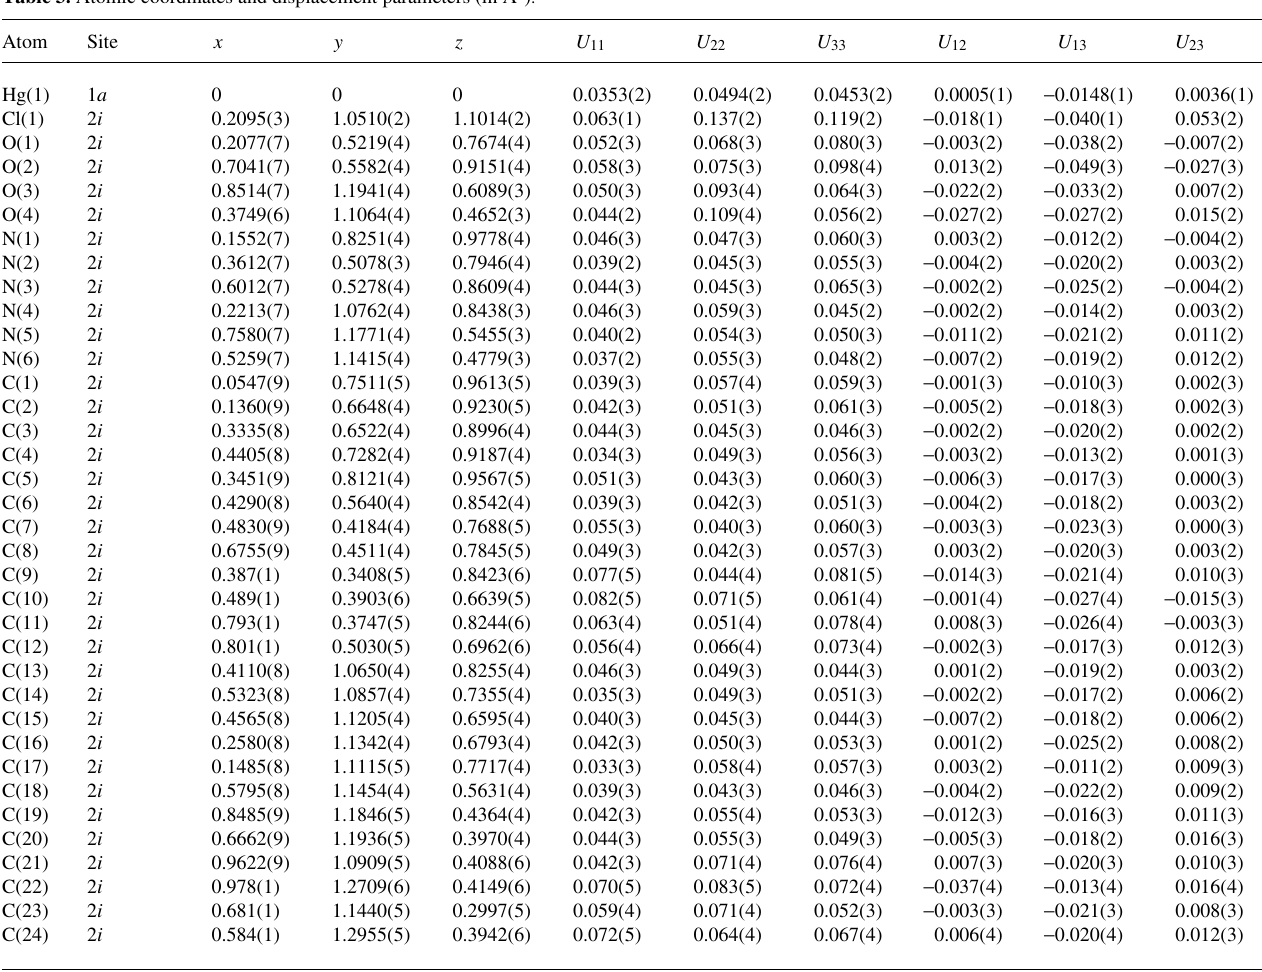
Table 3. Atomic coordinates and displacement parameters (in Å 2 )